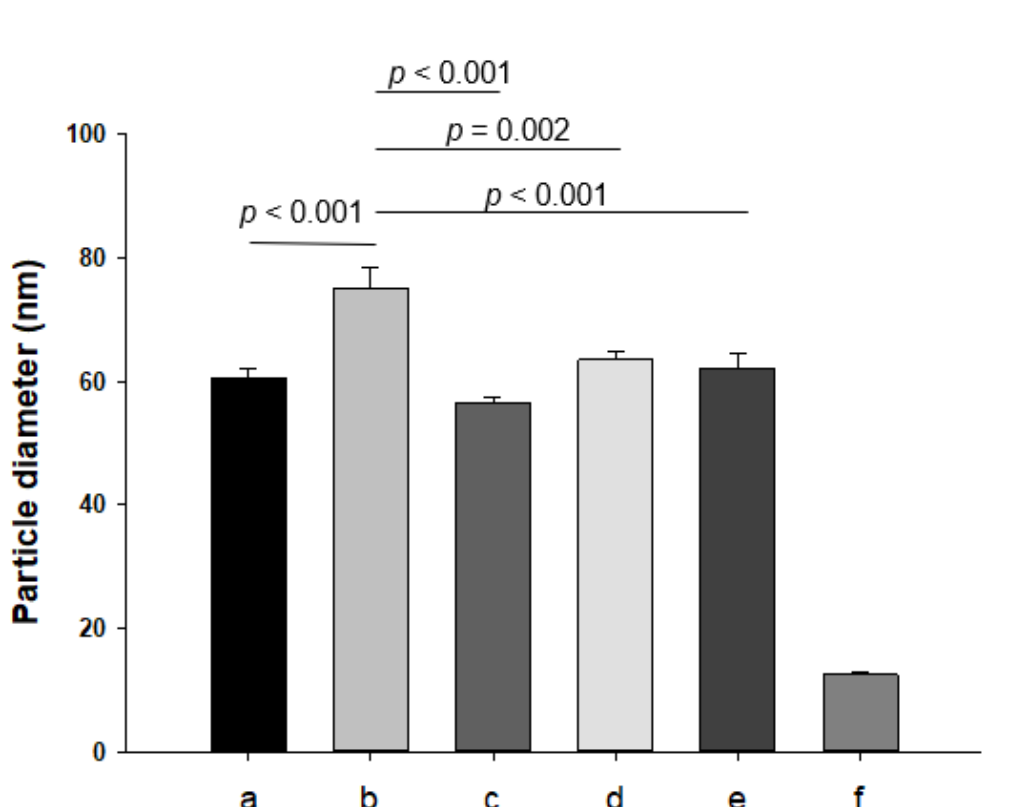
Figure 2. TEM image of each rHDL containing policosanol (photo a – e ) and human HDL 2 (photo f ) with 40,000 × magnification. Among rHDLs, rHDL-1 (photo b ) showed the biggest size (as shown in graph), the most distinct discoidal particle shape with a rouleaux pattern, and the highest particle number. Human HDL 2 from young and healthy males showed a spherical shape with a higher particle number.